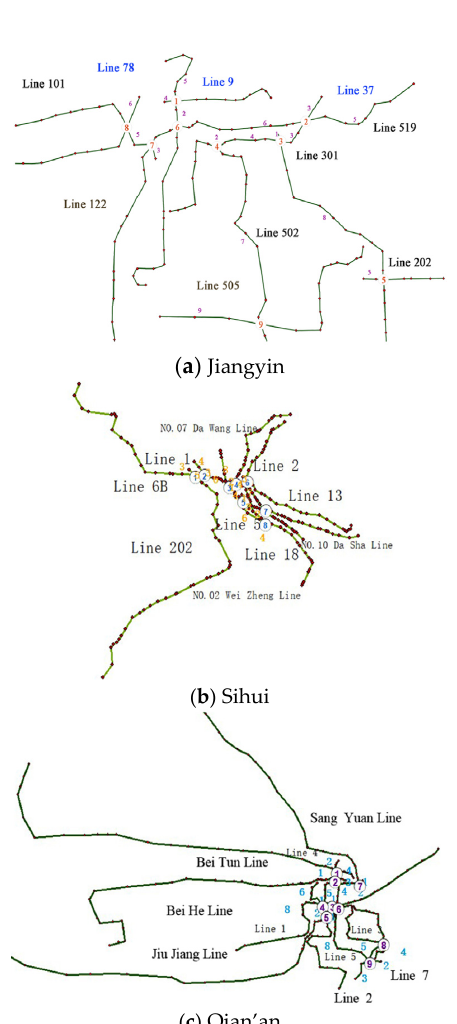
Figure 3. Transit networks.